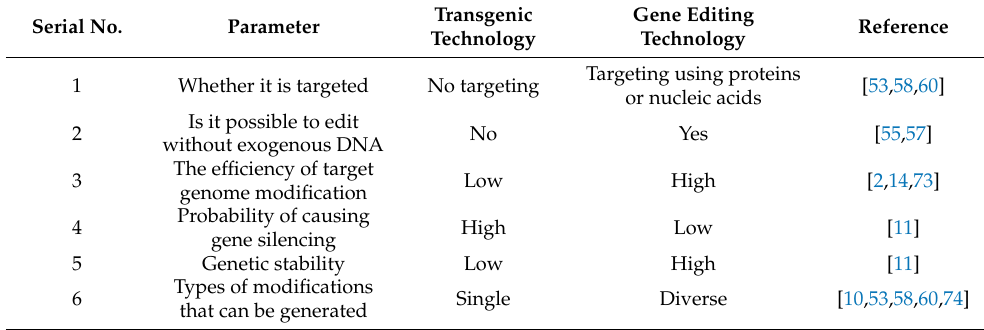
Table 1. Comparison between transgenic technology and gene editing technology. Serial